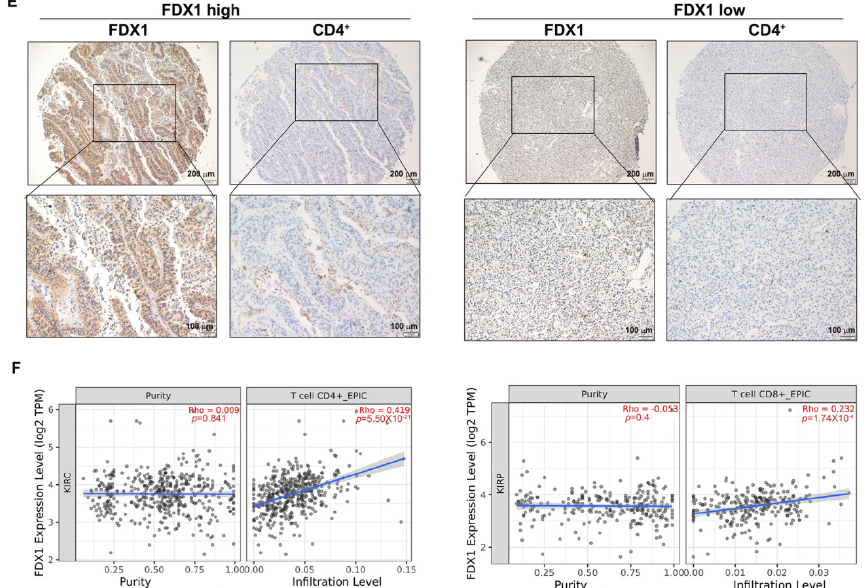
Figure 5. FDX1 correlates with the infiltration of CD4 + T cells in ccRCC. ( A ) Representative IHC images of FDX1 in different histological T stages of ccRCC. Scale bar: 200 µ m for the top images and 100 µ m for the bottom images. ( B ) Representative IHC images of FDX1 in different grades of ccRCC. Scale bar: 200 µ m for the top images and 100 µ m for the bottom images. ( C ) FDX1 was expressed at a higher level in ccRCC patients with histological T stage < T2 (left) or grade G1 + G2 (right) compared to their corresponding counterparts. n = 25 in T stage < T2; n = 26 in stage ≥ T2; n = 25 in G1 + G2; n = 26 in G3 + G4. ( D ) The FDX1 IHC score was positively correlated with the infiltration of CD4 + T cells in ccRCC (r = 0.2662, p = 0.03, n = 62). ( E ) Representative images of the correlation between FDX1 intensity and CD4 + T cell infiltration. Scale bar: 200 µ m for the top images and 100 µ m for the bottom images. ( F ) Immune cell infiltration analysis of the TCGA-KIRC dataset using TIMER 2.0 showed that FDX1 expression was positively correlated with CD4 + and CD8 + T cell populations. * p <